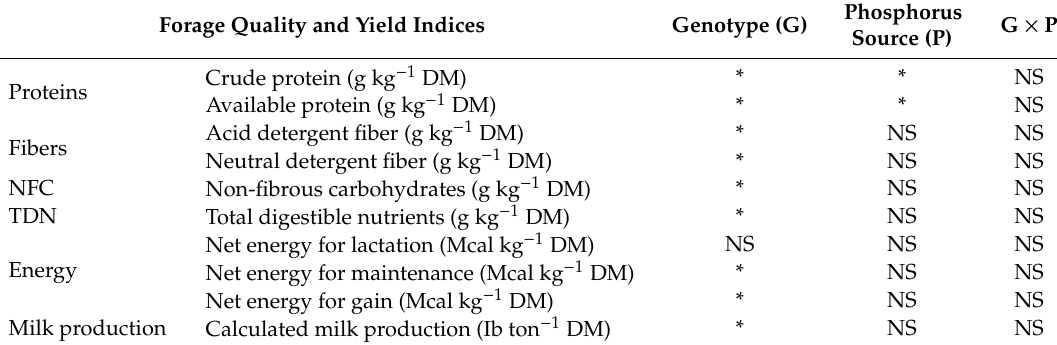
Table 5. Analyses of variance (ANOVA) regarding forage yield and quality indices of silage-corn 203